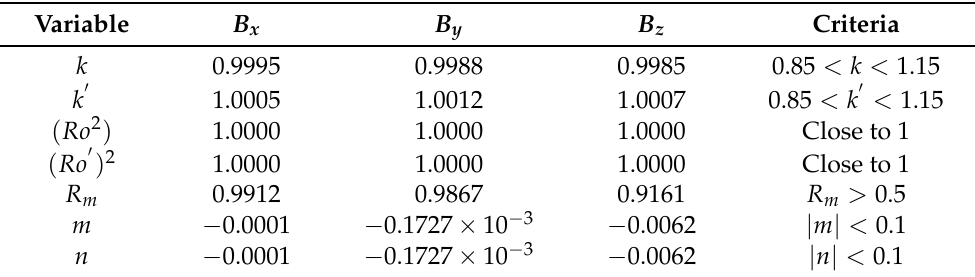
Figure 17. 3D Scatter plots of optimized ANN/SA algorithms for ( a ) B x , ( b ) B y , ( c ) B z , and ( d ) B . Table 3. Extra evaluations for